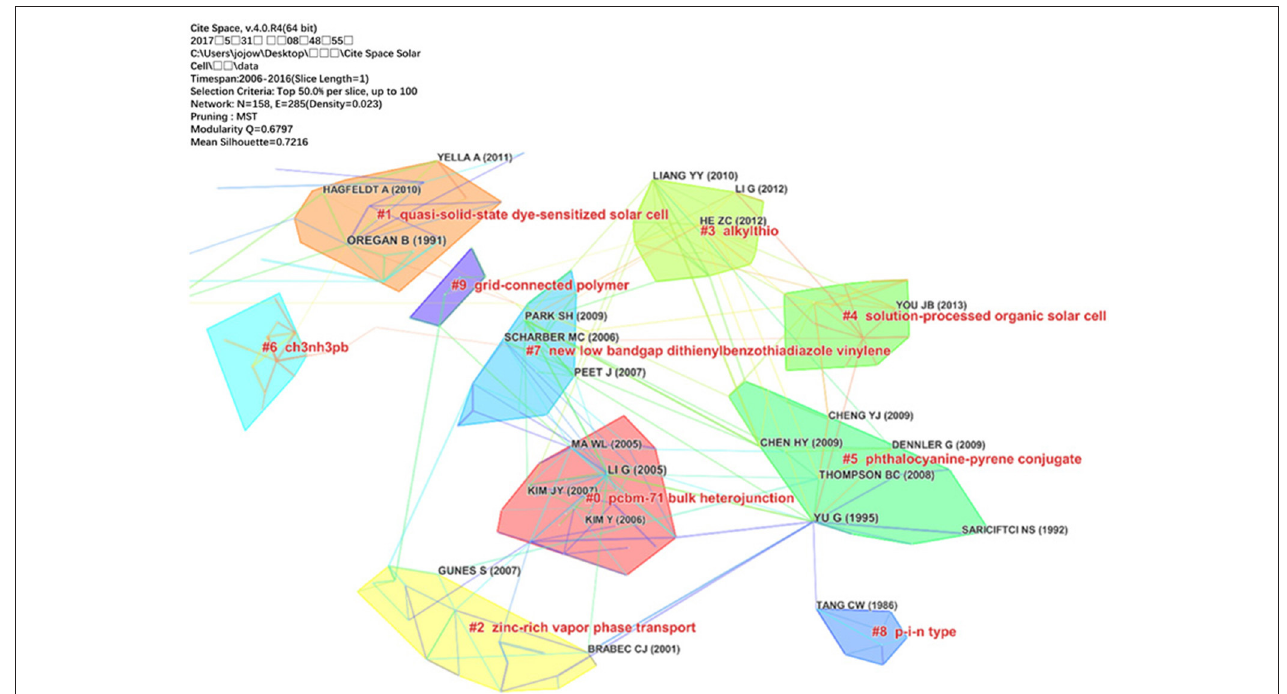
FIGURE 4 | Clusters visualization based on a document co-citation network of 2006–2016.